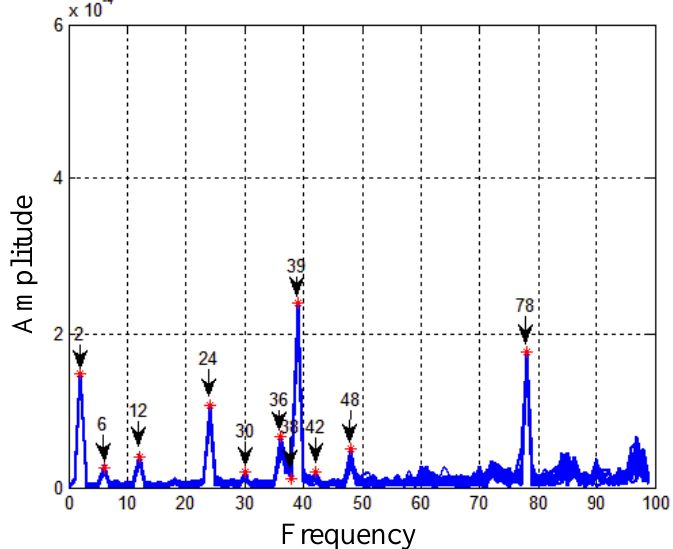
Figure 10. Spectrum